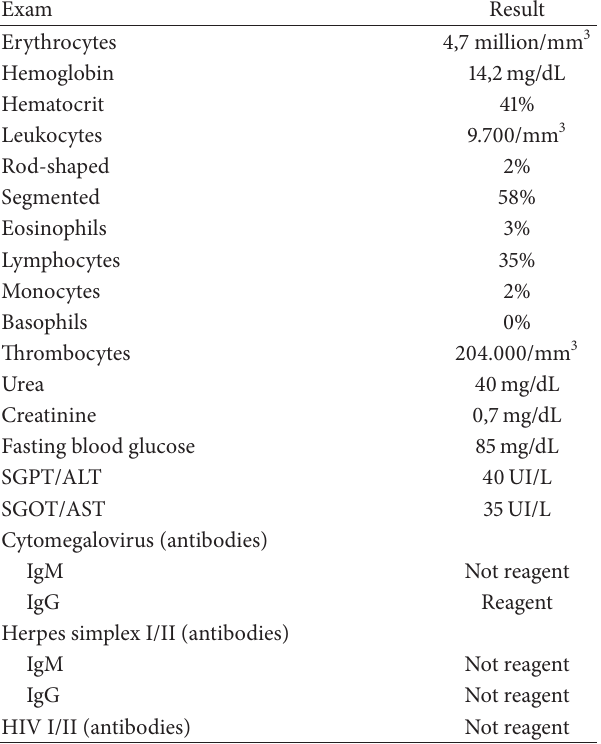
Table 1: Tests performed on the patient.